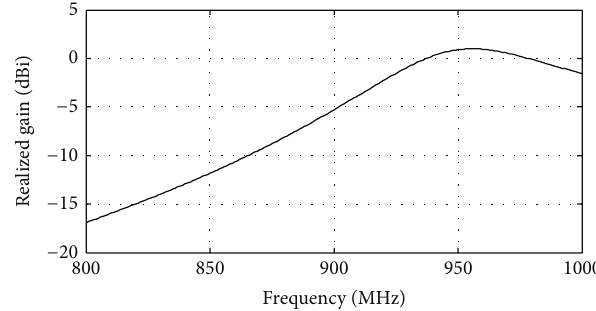
Figure 3: Reference tag realized gain in + 𝑧 -axis in